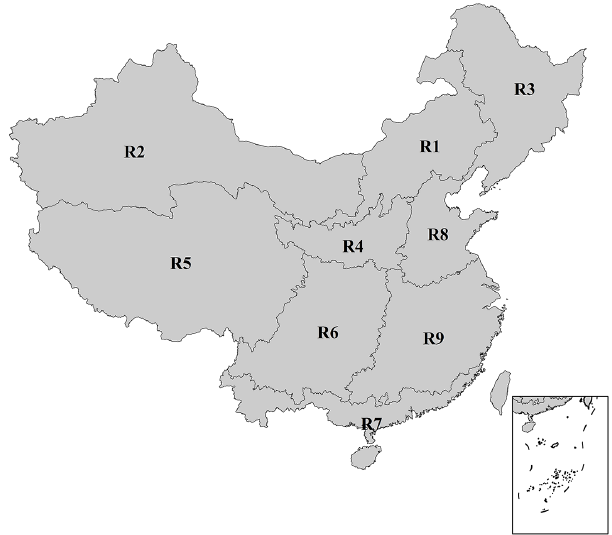
Figure 1. The forest cover map of China. forest types in the 31 provinces of China, excluding Taiwan, Hong Kong, and Macao.